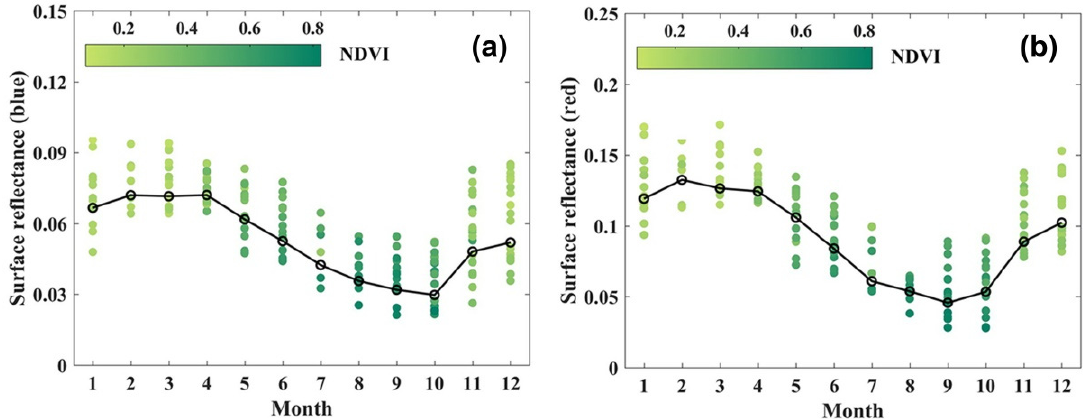
Figure 4. Variation in the surface reflectance in each month for blue ( a ) and red ( b ) bands corresponding to NDVI; the black circle and black line represent the average minimum 20% to 50% of LSR in each month and the trend for each month over the mixed pixels.